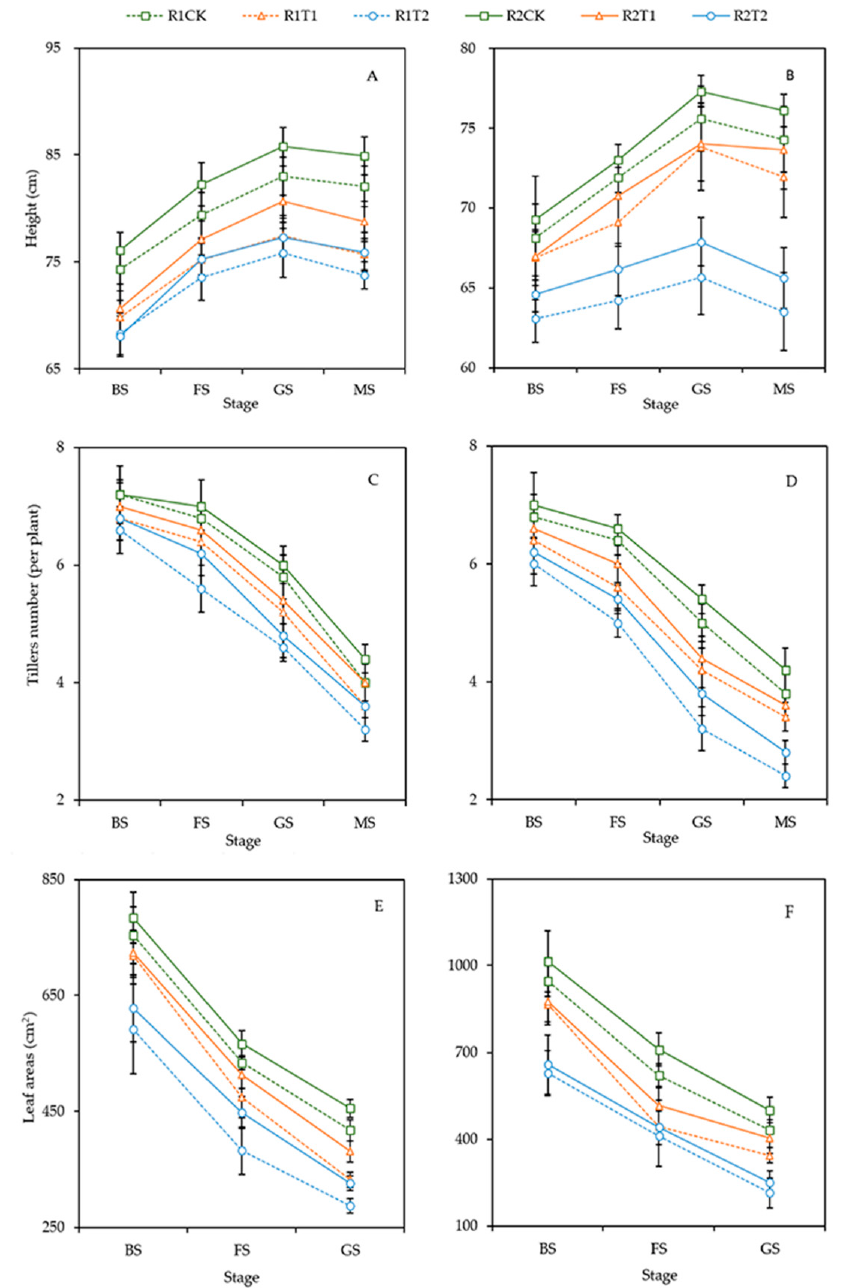
Figure 2. Effects of OPA on wheat morphology under low-temperature stress at booting, flowering and grain-filling stages. ( A ) Plant height of YN19. ( B ) Plant height of XM26. ( C ) Tiller number of YN19. ( D ) Tiller number of XM26. ( E ) Leaf areas per plant of YN19. ( F ) Leaf areas per plant of XM26. Data represent means ± SE ( n = 3). Vertical bars represent standard errors. Abbreviations: YN19 = Yannong19; XM26 = Xinmai26; BS = booting stage; FS = flowering stage; GS = grain-filling stage; MS = maturity stage. R1CK, R1T1 and R1T2 represent 11 °C, 4 °C and − 4 °C under traditional phosphorus application, respectively; and R2CK, R2T1 and R2T2 represent 11 °C, 4 °C and − 4 °C under optimized phosphorus application, respectively.